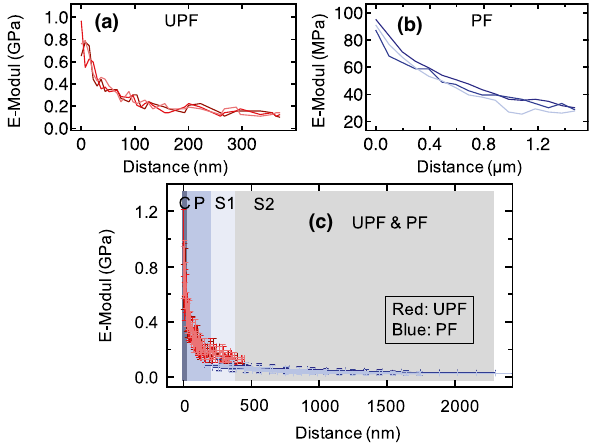
Fig. 5 Depth profiles of this Elok(z) of ( a ) a UPF, ( b ) a PF and ( c ) a combined graph of UPF and PF. In ( c ), the UPF profiles are plotted in red, and the PF profiles are plotted in blue. The suggested cor- responding wall layers are indicated with different colours. The C layer is highlighted in dark blue, the P wall in blue, the S1 layer in light blue and the S2 layer in grey. The error bars are ± 30% of the values. The three profiles in ( a ) and ( b ) were extracted from cross sections with a HSC cantilever. The profiles in ( c ) were extracted with both cantilever types. The maximum indentation in z-direc- tion was reached for PF with 1233 nm and for UPF 485 nm. Thus, we did not consider that the hollow lumen affects the measured the Elok(z)values